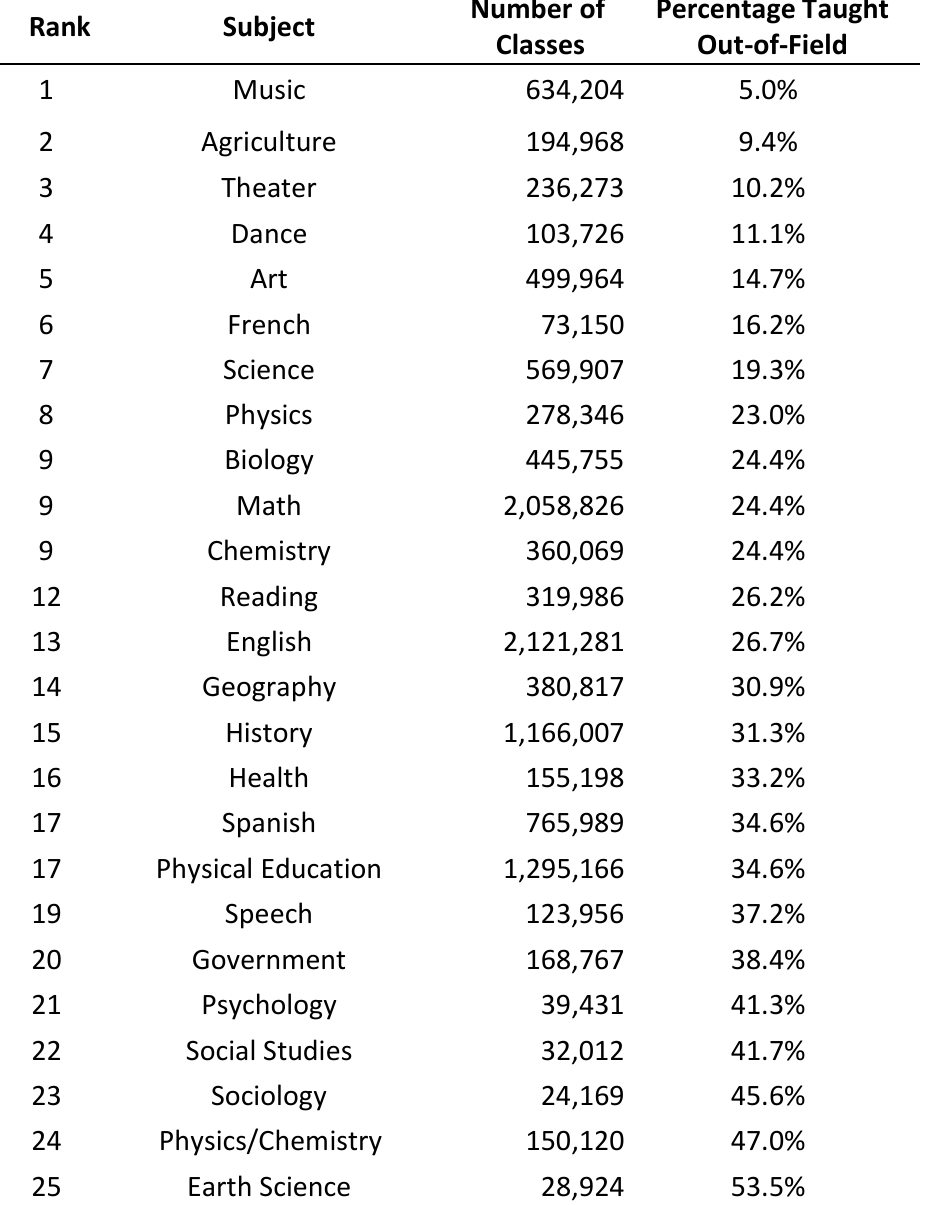
Table 1 : Number of Classes Taught by Subject and Percentage Taught